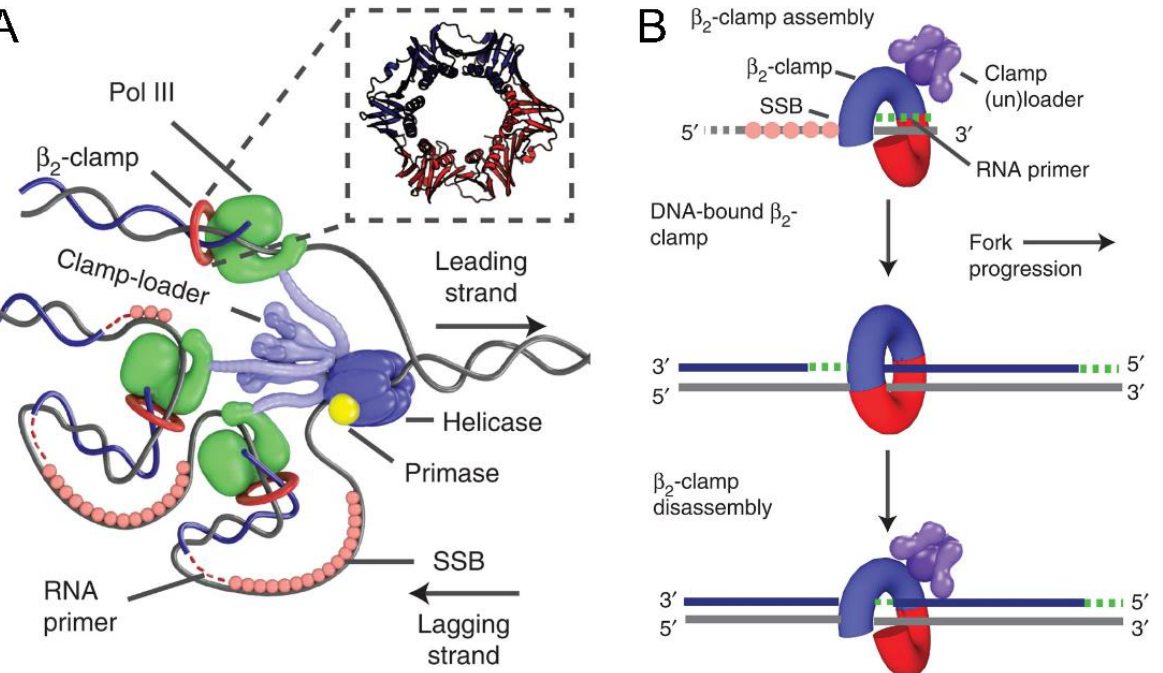
Figure 3. The role of the sliding clamp during replication. ( A ) The figure represents the E. coli replisome and the position of the clamp. The sliding clamp is loaded onto the primer-template junction by the clamp loader complex. The clamp consists of two hydrophobic pockets through which the polymerase and other proteins of the replisome interact with it. ( B ) The clamp loader complex opens the clamp, loads it onto the DNA, and is then ejected with the hydrolysis of ATP. Once the synthesis